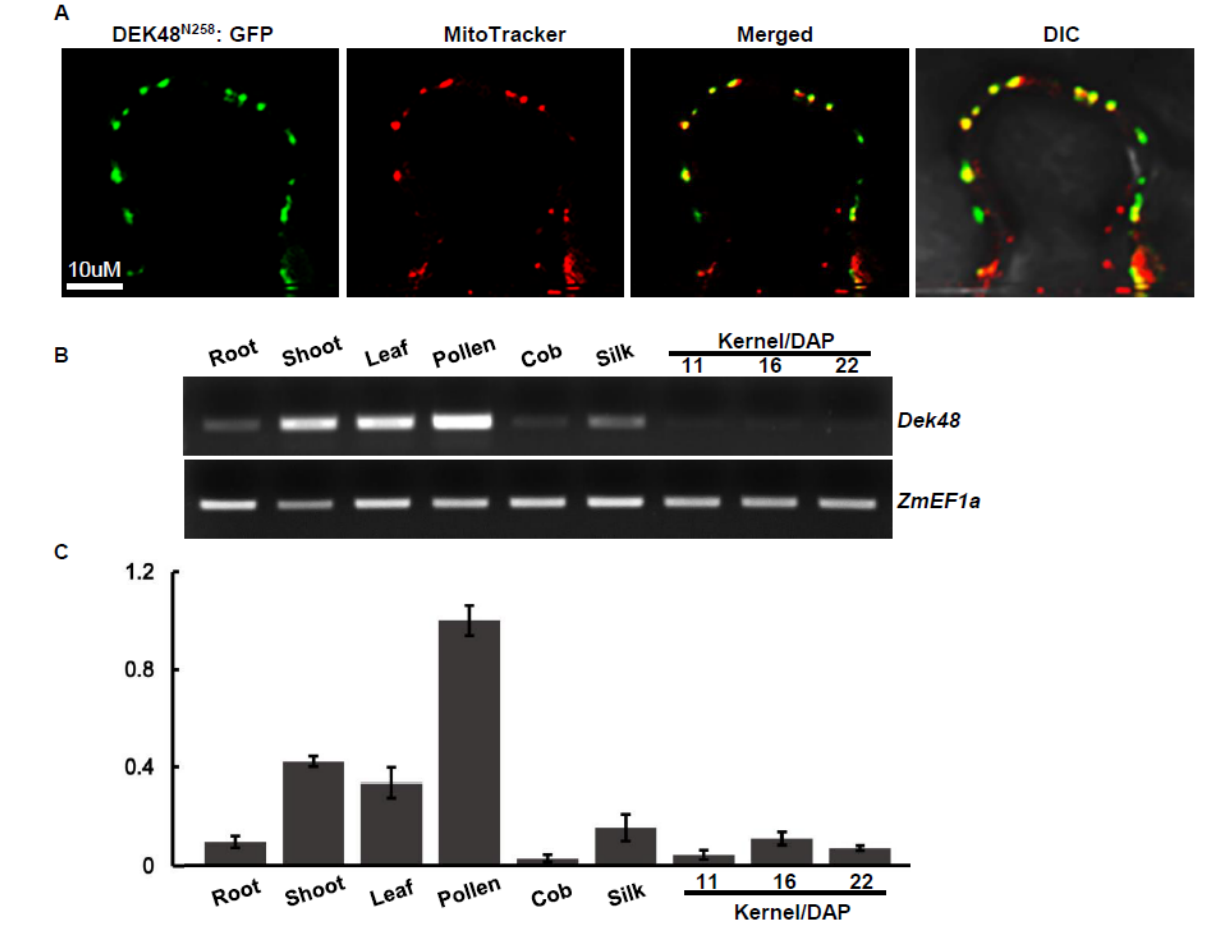
Figure 5. DEK48 is targeted to mitochondria. ( A ) Subcellular localization of DEK48. A DEK48 N258 - GFP fusion protein was transiently expressed in tobacco epidermal cells. MitoTracker Red was used as a mitochondrial marker. DIC, differential interference contrast; N258, the N terminus 258 amino acids of DEK48. Scale bars = 10 µ m. ( B ) Semi-quantitative RT-PCR analysis of Dek48 expression in WT tissues and developing kernels. Normalization was performed against ZmEF1 α ( GRMZM2G153541 ). ( C ) Quantitative RT-PCR analysis of Dek48 expression in WT tissues and developing kernels. Normalization was performed against ZmEF1 α ( GRMZM2G153541 ). Data are means (± SE) of three biological replicates.